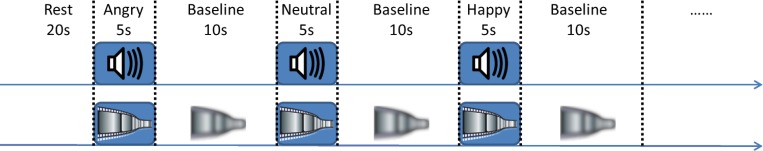
Experiment design.The streamline demonstrates the timeline of the experimental task stimulus presentation and baseline. The task started with a 20-sec rest period, followed by a 5-sec stimulation presented. A 5-sec silent cartoon video was shown during each stimulation presentation trial to attract infant attention and reduce motion artefact. After each stimulation trial, a 10-sec silent blurred, cartoon baseline was presented. The silent cartoon was the same for all the stimulation conditions (angry, neutral and happy).